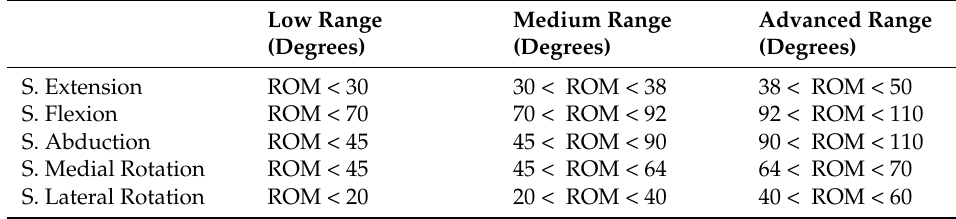
Table 1. Shoulder Range Division.